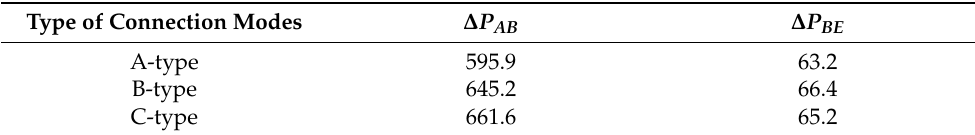
Table A1. Pressure drop across furnace and cyclones (Exp. unit of Pa).